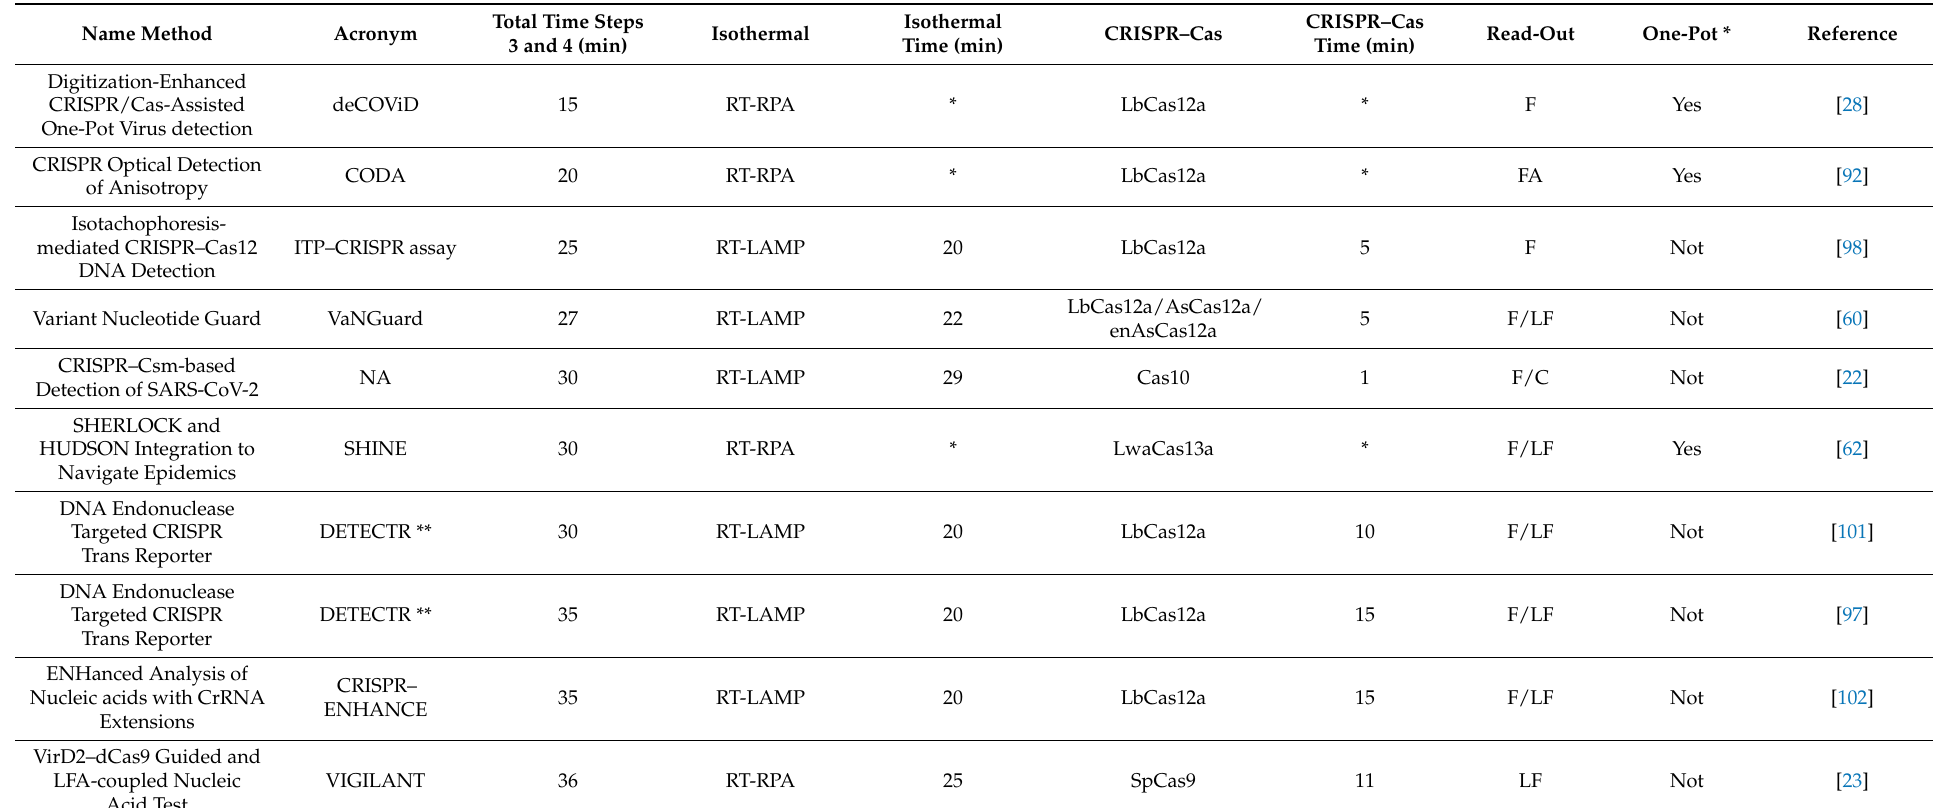
Table 2. List of CRISPR-based methods with shortest total time for steps 3 and